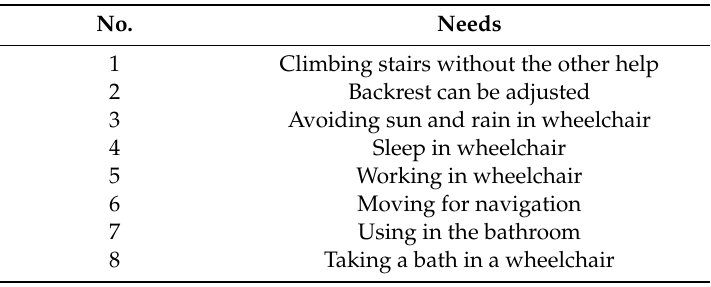
Table 2. User needs for a